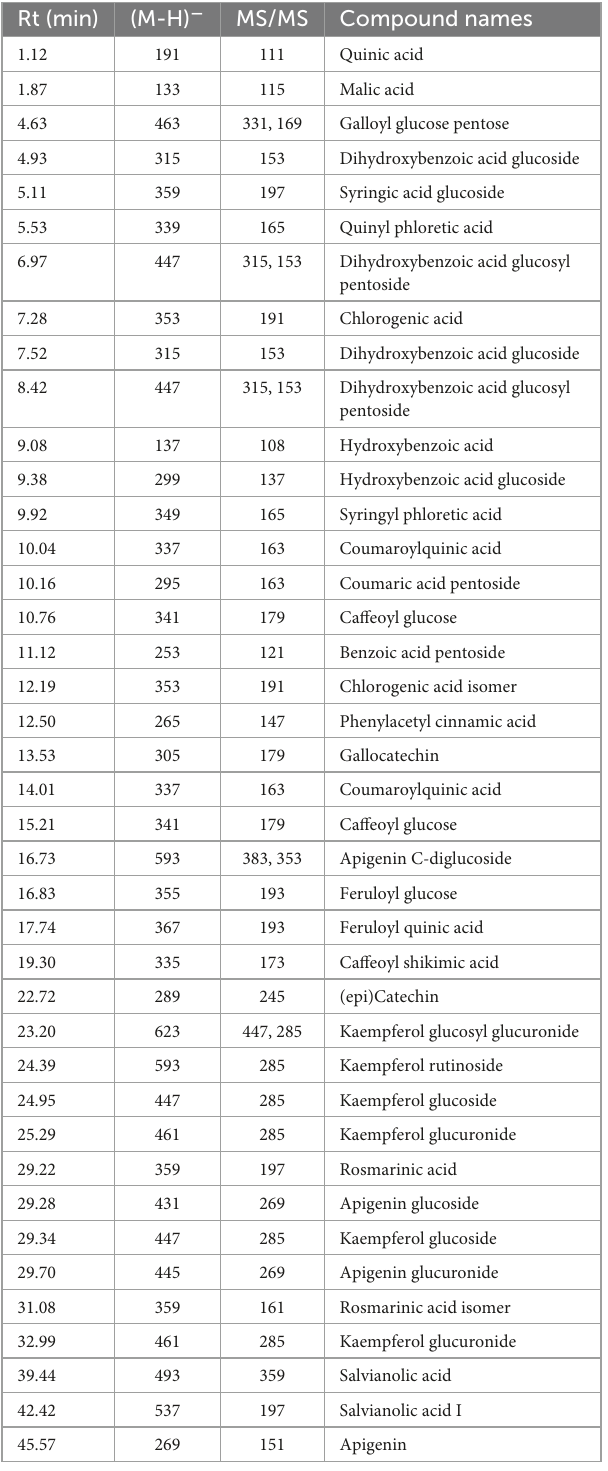
TABLE 1 Annotated phytoconstituents from Mentha rotundifolia leaves aqueous extract using